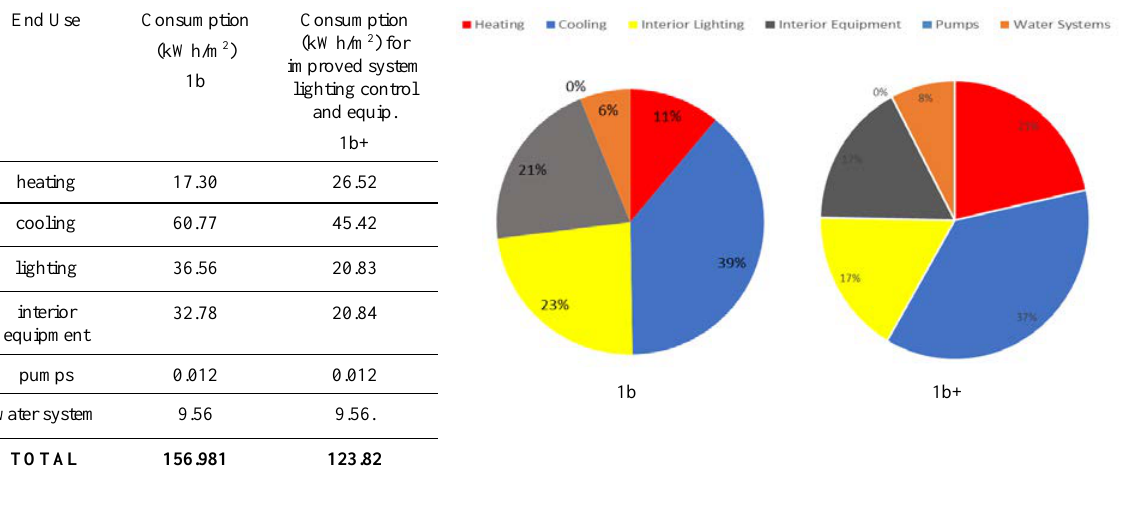
Table. 7. Energy consumption for a newly designed model and total consumption percentage (triple glazed